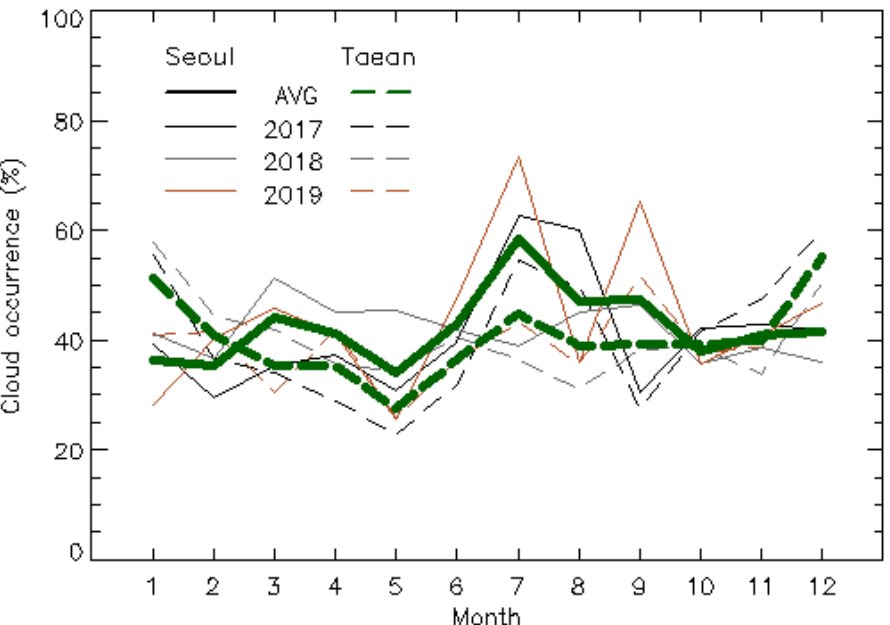
Figure 3. Annual variations of monthly averaged cloud occurrence (AVG) (0–7750 m) derived from ceilometer measurements at Seoul and Taean from 2017 to 2019. Each annual variation of monthly cloud occurrence is averaged at both Seoul (Seoul_S1 and Seoul_S2) and Taean (Taean_T1 and Tanean_T2) stations.